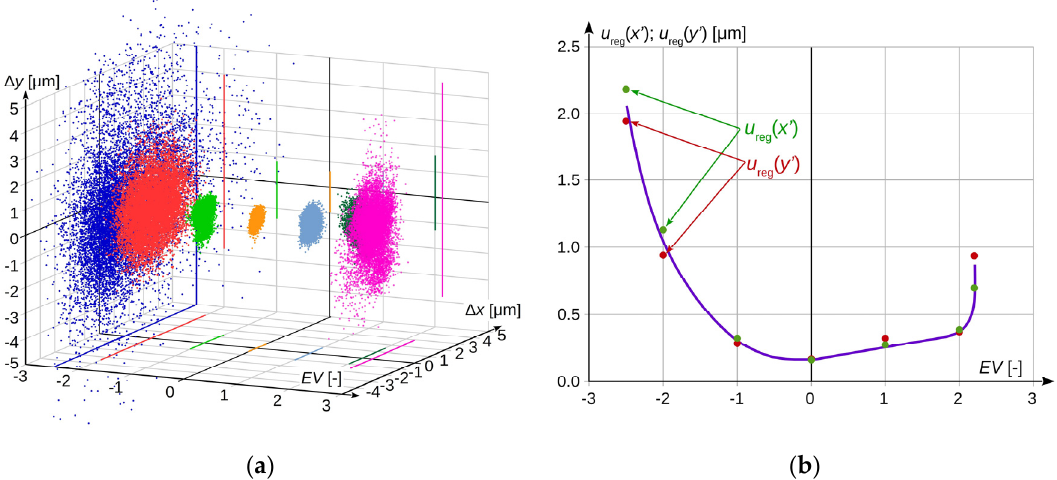
Figure 4. Influence of the image registration parameters: ( a ) stochastic distribution of the obtained measurement result depending on the brightness level of the recorded image; ( b ) uncertainty for the measurement in the horizontal axis u reg ( x’ ) and vertical axis u reg ( y’ ) in the function of changing the brightness of the recorded image.